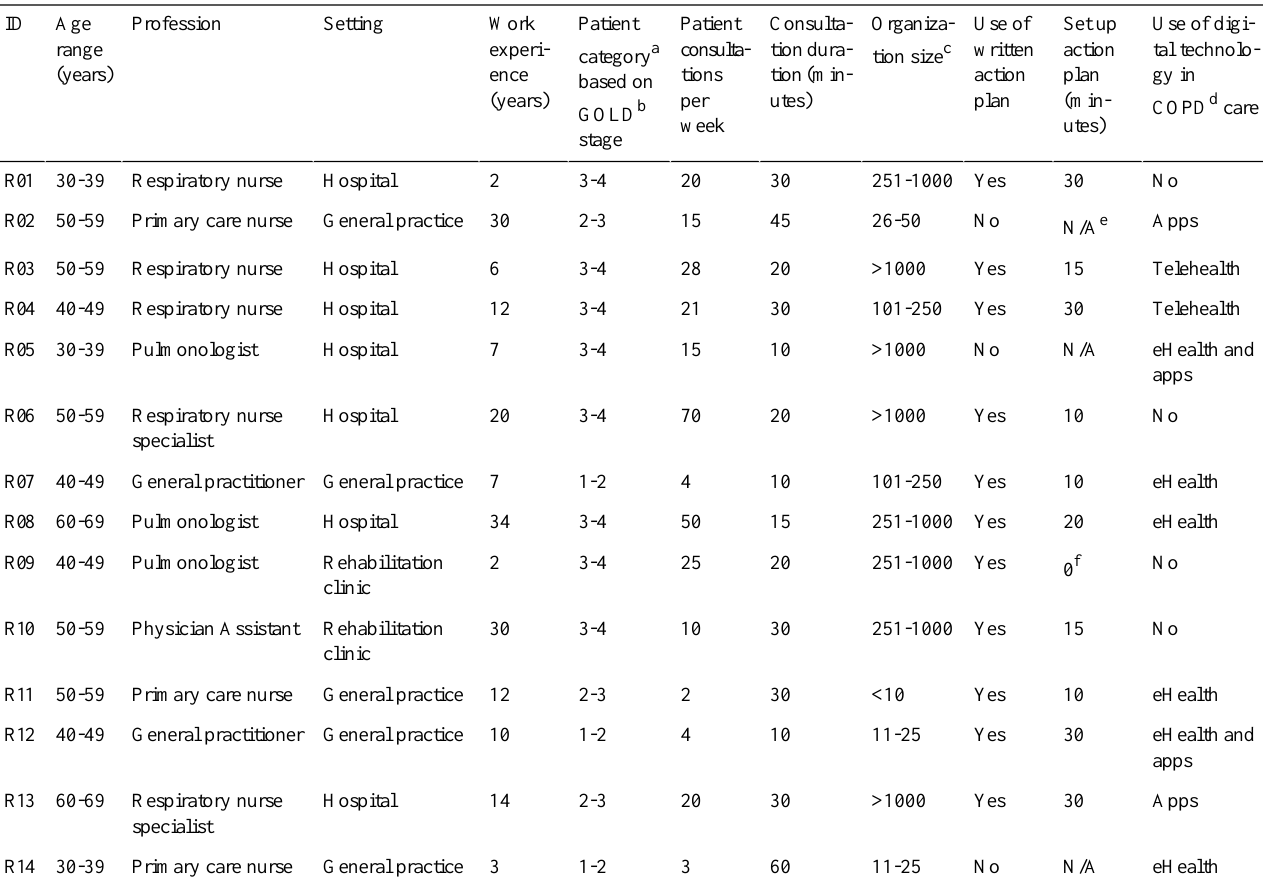
Table 2. Baseline characteristics of the